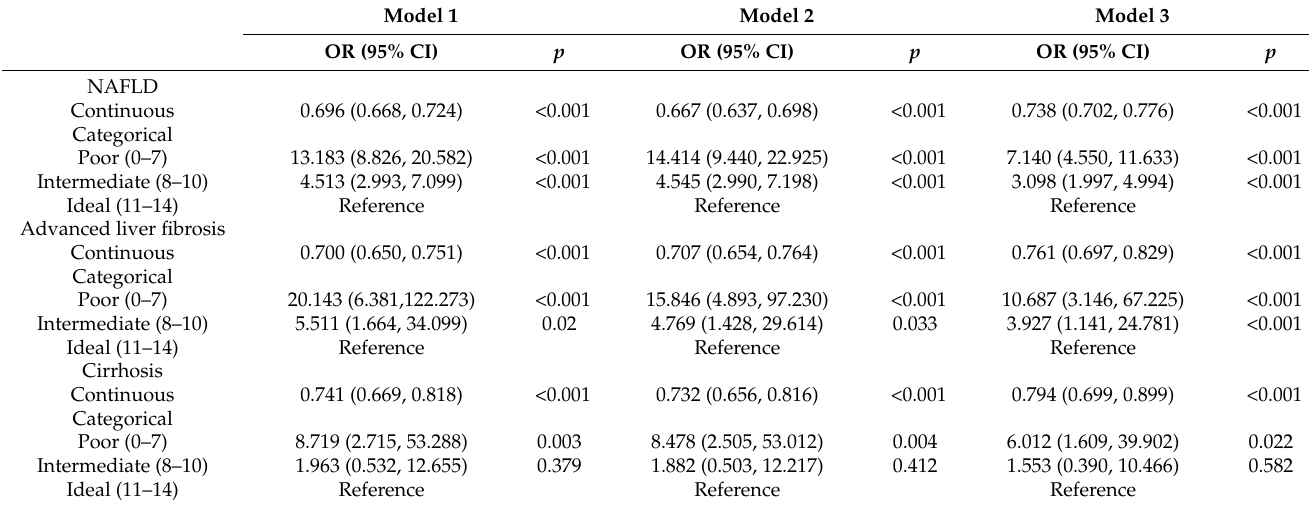
Table 3. Logistic regression model between NAFLD, liver fibrosis, cirrhosis and CVH metrics.